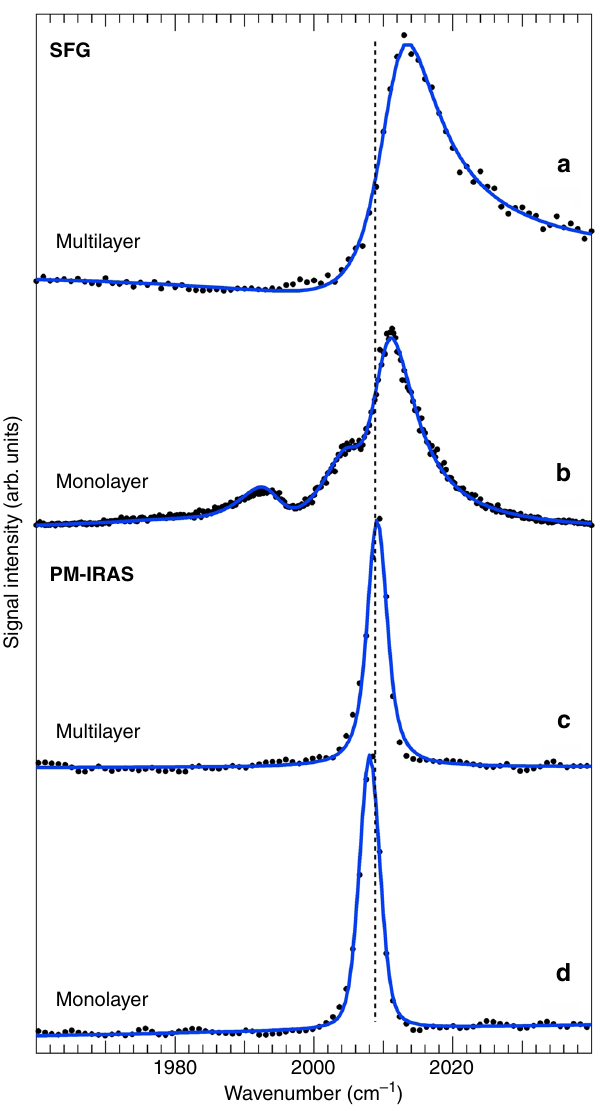
Fig. 4 Vibrational vs. vibronic fi ngerprints of the C – O stretching mode for the carbonylated FePc monolayer. Comparison between IR-Vis SFG ( a and b ) and PM-IRAS ( c and d ) intensity spectra collected in situ at room temperature in 10 mbar CO in the C – O stretching region for the carbonylated FePc monolayer ( b and d ) and multilayer ( a and c ) on graphene. For the IR-Vis SFG spectra, λ Vis = 532 nm and ppp polarization were